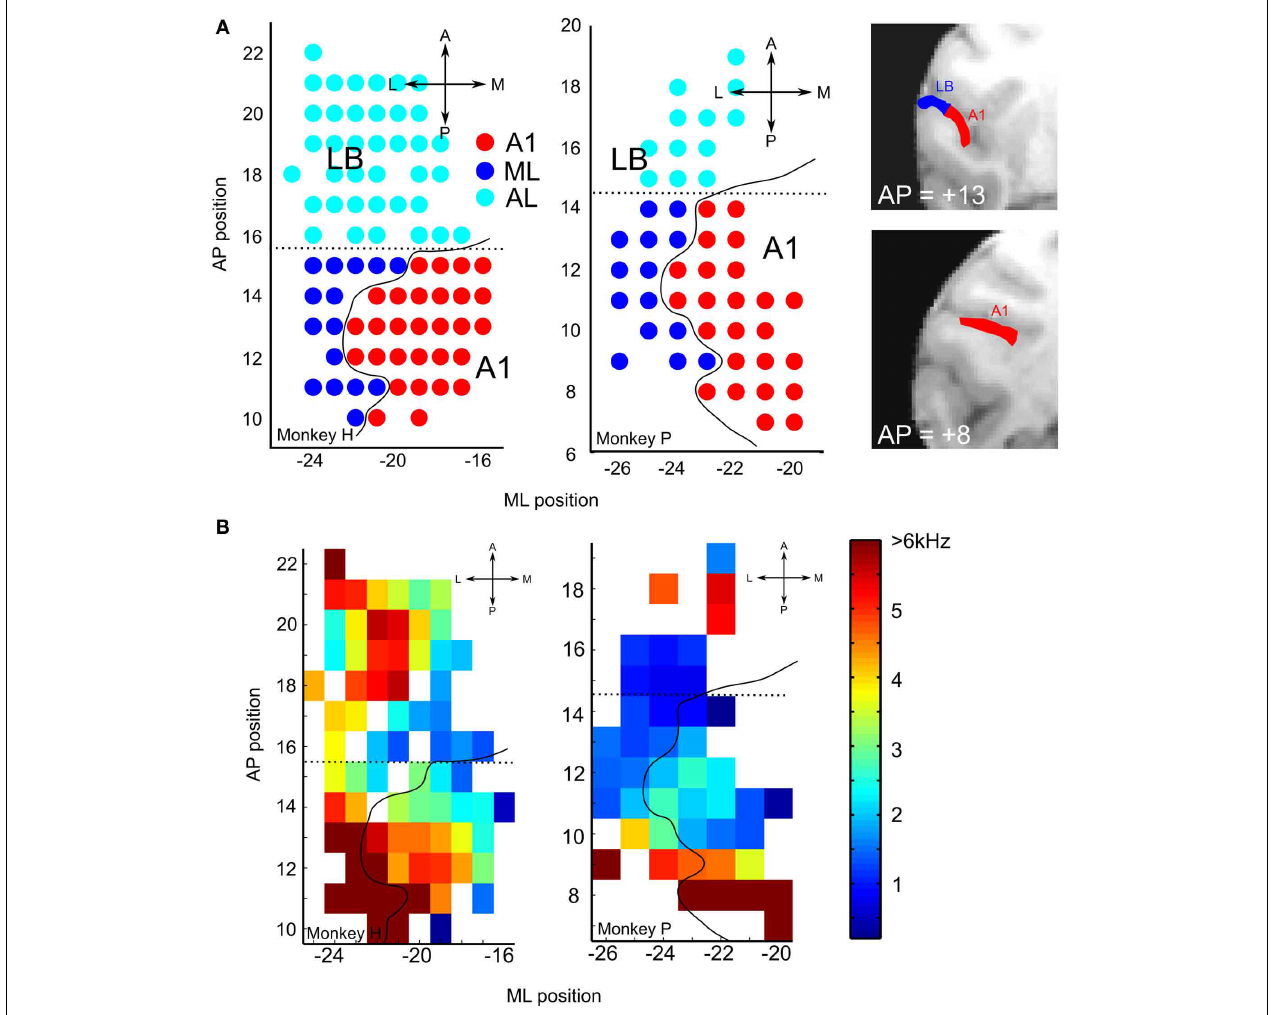
FIGURE 2 | (A) Recording sites: the location of A1 and lateral belt (LB) are depicted on the left supratemporal plane (STP) of Monkeys H and P. The anterior-posterior (AP) and medial-lateral (ML) coordinates were transformed into standardized coordinates based on the population-average macaque brain (McLaren et al., 2009, 2010). The curved solid black line on each map shows the estimated border between core and LB based on the atlas from a single subject (Saleem and Logothetis, 2007). The anterior-posterior border (dotted line) was drawn from the frequency reversal observed on mapping the best frequencies (BFs, see Figure 2B ); this reversal occurred at a slightly different AP coordinate in the two monkeys